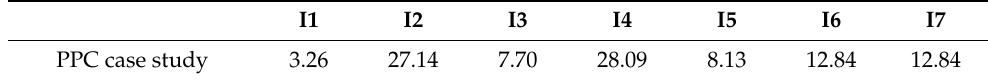
Table 9. Weights of the material selection indices calculated for the case study.